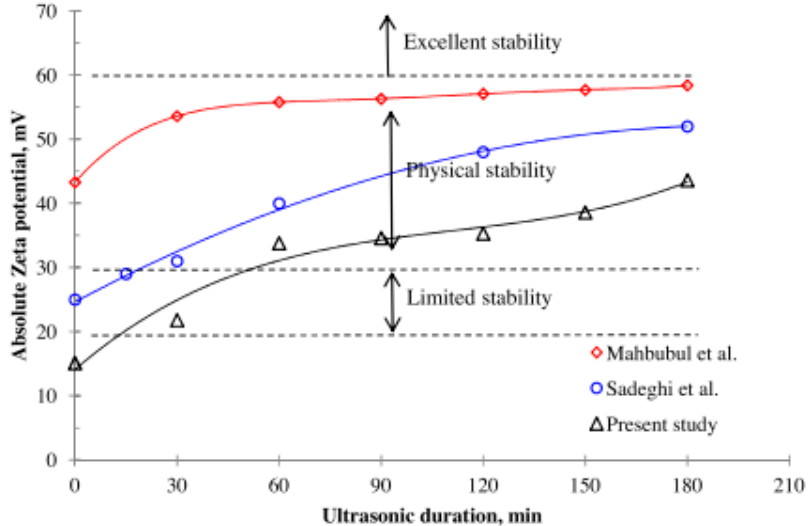
Figure 4. Effect of ultrasonic duration on stability of TiO 2 /water nanofluid. Adapted from [95].